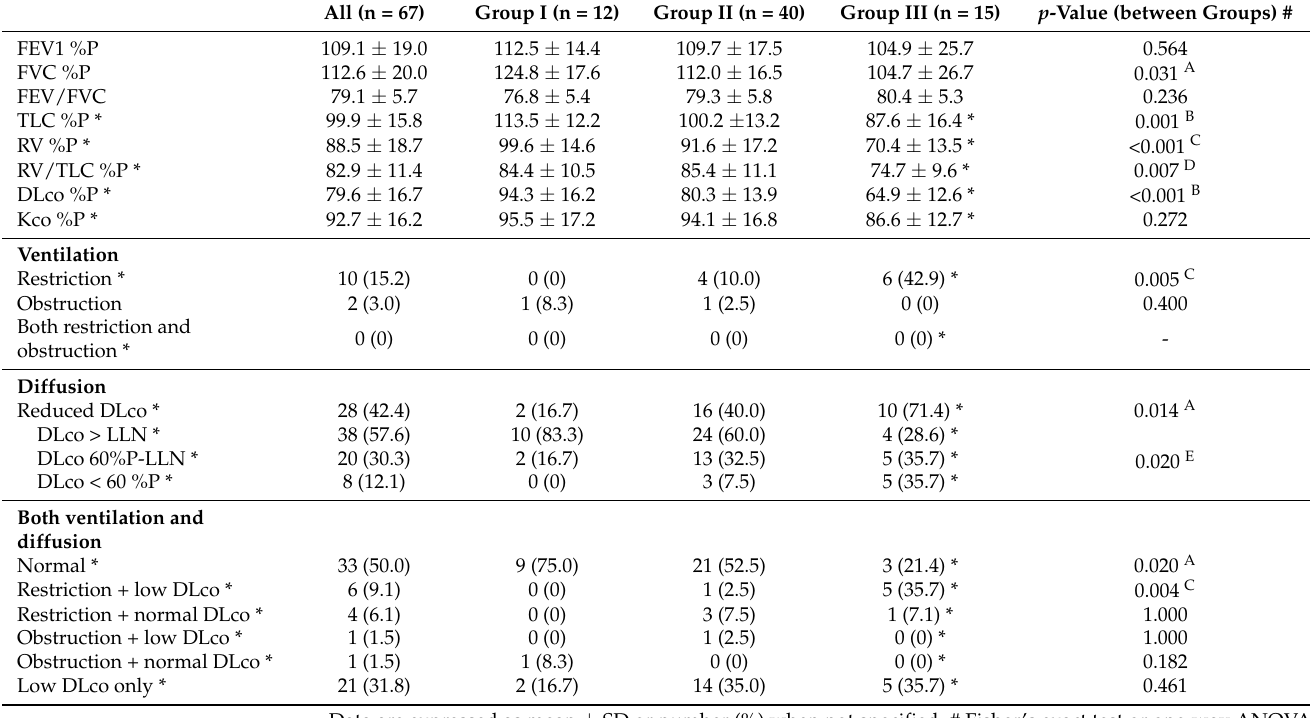
Table 2. Lung function outcome 4 months after COVID-19 (n = 67) and differences between patients who were not hospitalised, hospitalised without ICU and with ICU treatment.